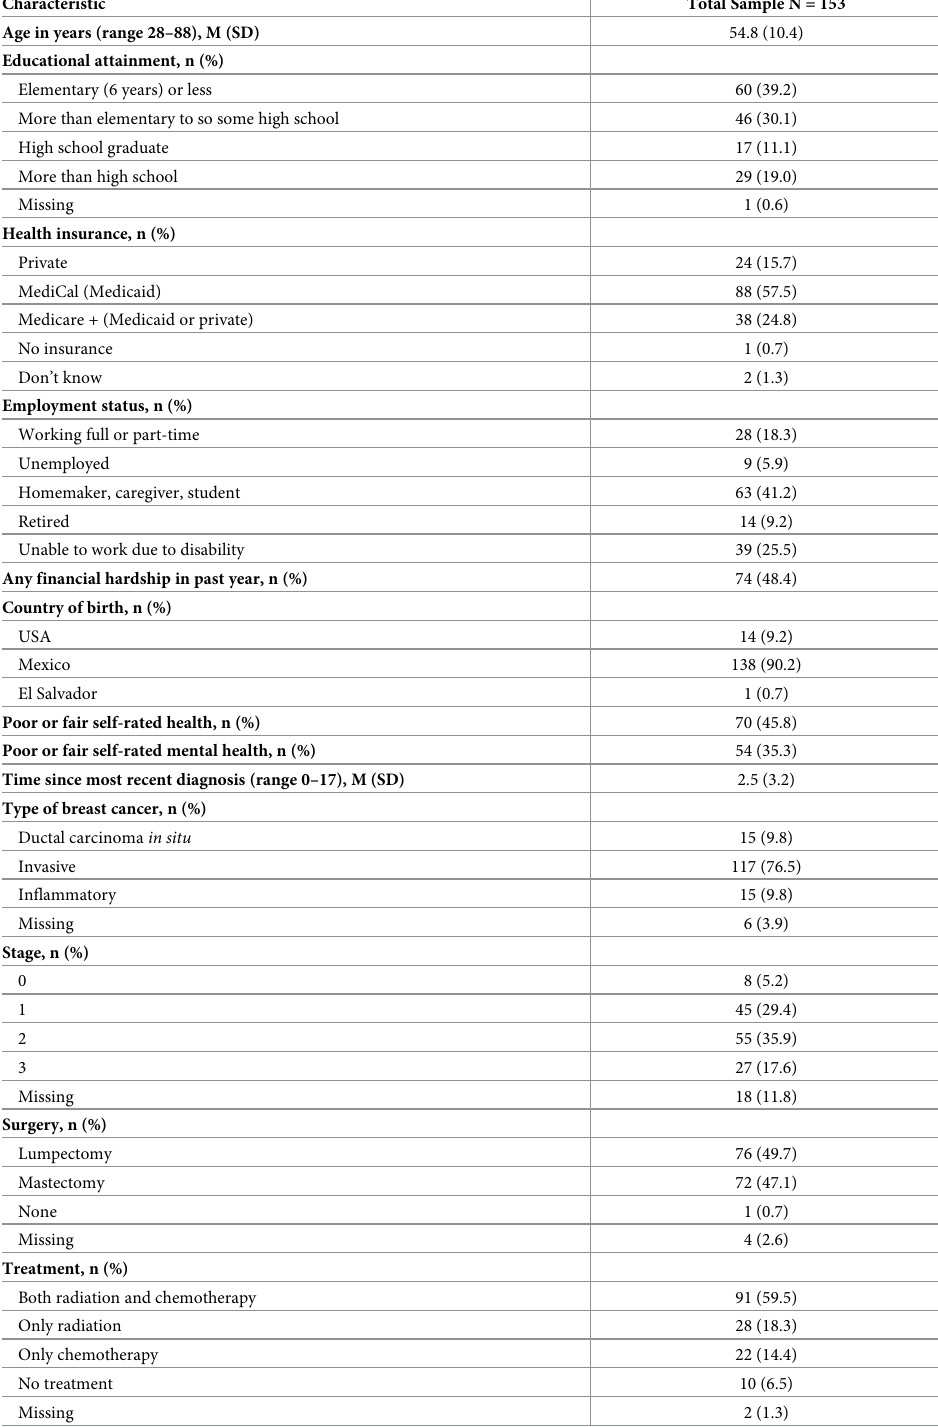
Table 2. Baseline characteristics of rural Spanish-speaking Latina breast cancer survivors participating in the Nuevo Amanecer-II study, California, September 2016 to March